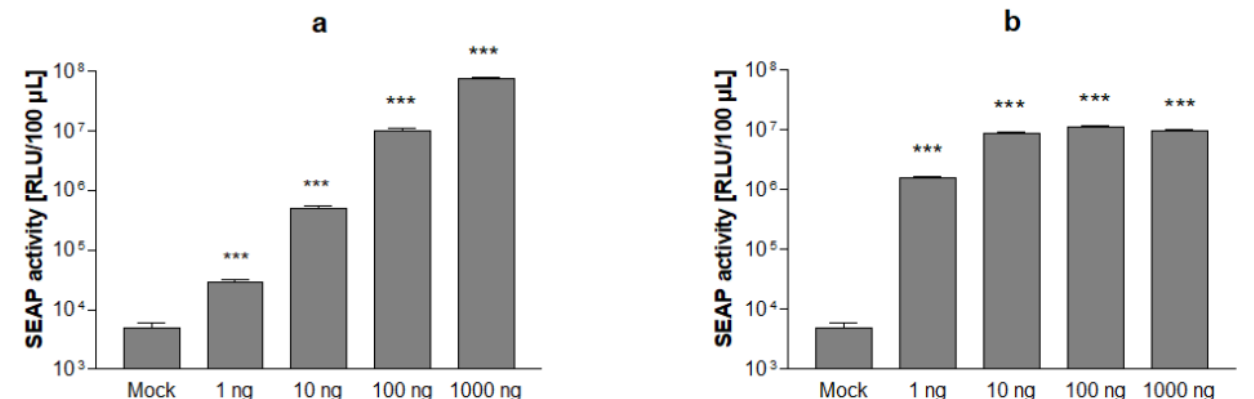
Figure 2. Induction of SEAP expression in Vero indicator cells. Stable cell lines Vero CMVTet3G and Vero TRE3G-SEAP-EYFPNuc mixed at a 1:1 ratio and cultivated in 24-well plates were transiently transfected with pTRE3G-SEAP-EYFPNuc ( a ) and pCMV-Tet3G ( b ) as indicated. SEAP levels in culture supernatants after cultivation in the presence of 10 µg/mL doxycycline for 48 h are shown. Data represent means ± SD from quadruplicates. Significance is indicated compared to non-transfected control (Mock), p < 0.001 (***).